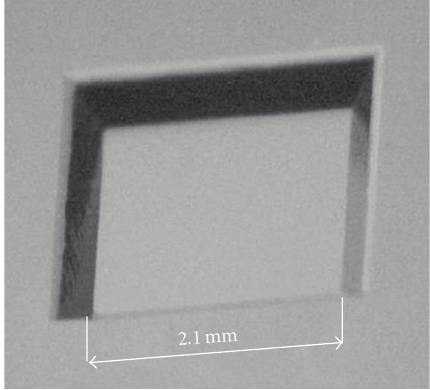
Figure 24: Example of ultrasmall microphone, diaphragm [66].